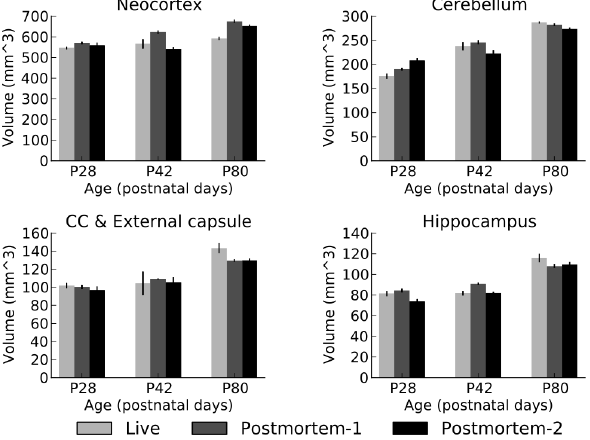
Figure 4. Volume of selected regions as a function of age and scan